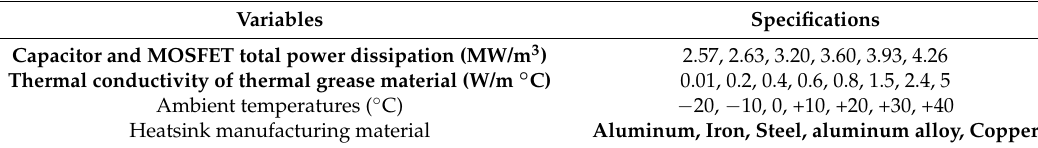
Table 3. Applied conditions for the numerical simulation of the 36V electric bicycle ECU.